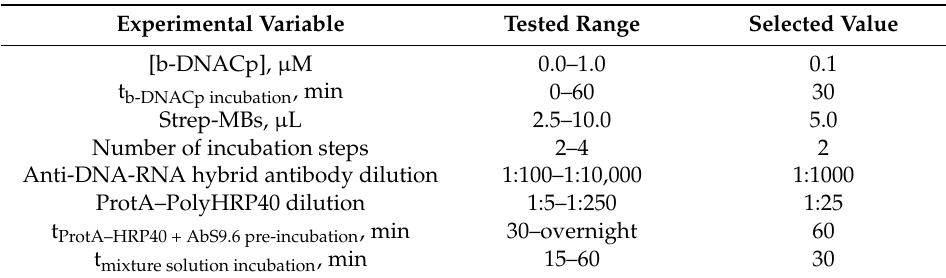
Table 1. Optimization of the experimental variables affecting the performance of the amperometric biosensor developed for miRNA-21 determination.